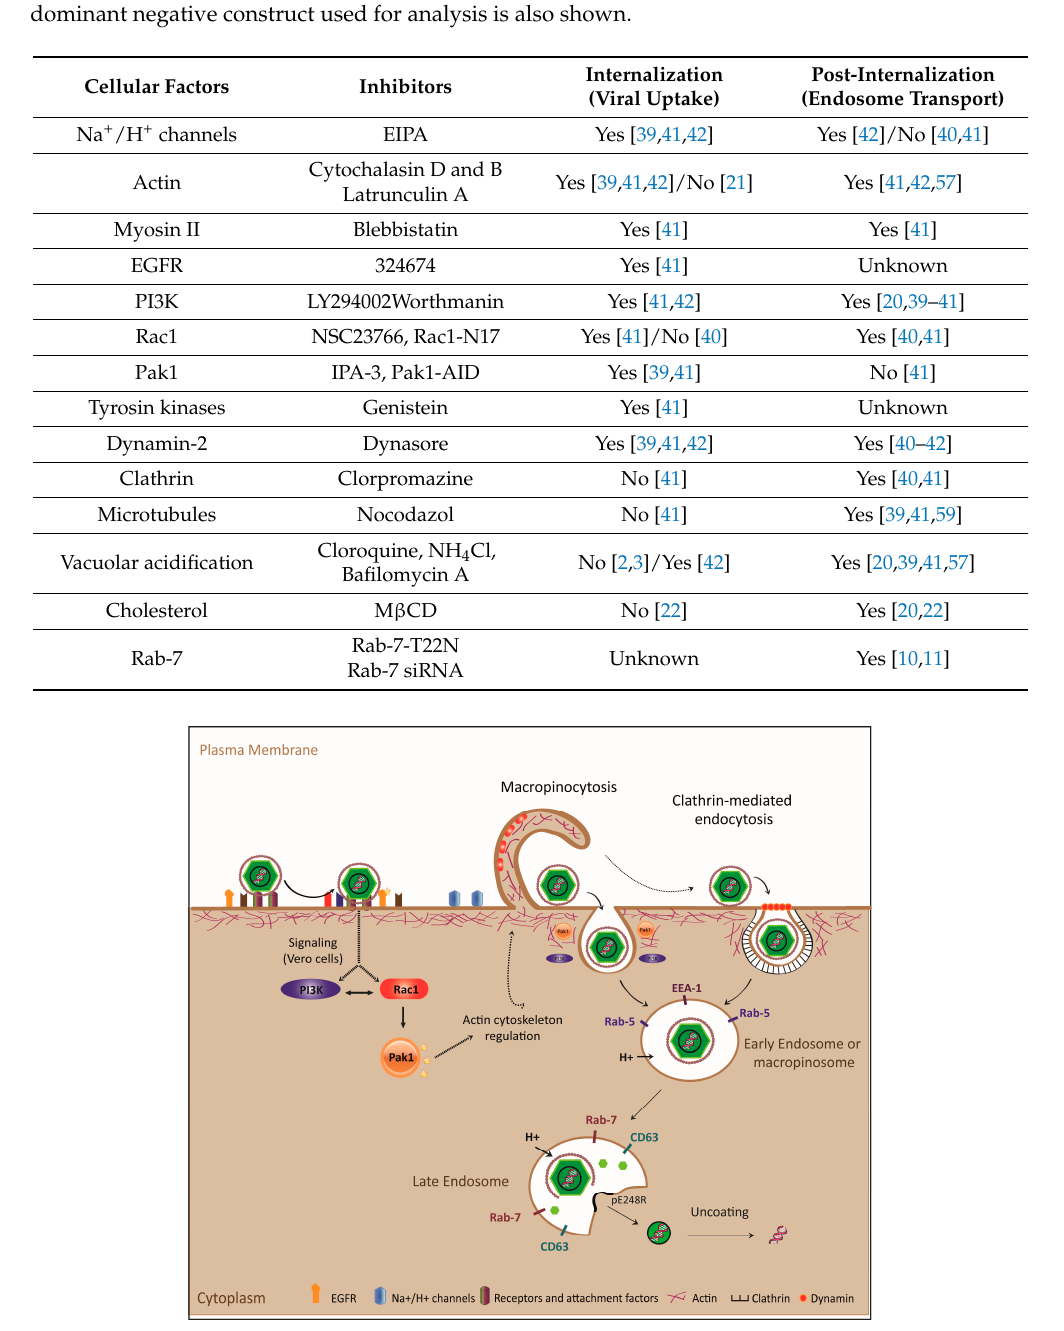
Figure 3. Model for ASFV entry and uncoating. Interaction of the viral particle with membrane receptors and attachment factors activates PI3K, EGFR, Rac1 and Pak-1 signaling pathways, which regulate actin dynamics, forming ruffles to internalize by macropinocytosis in Vero cells. In the case of swine macrophages, although the virus uses macropinocytosis, it does not actively induce the pathway; ASFV is also able to enter cells by CME. After viral uptake, particles are endocytosed in early endosomes or macropinosomes and transported to late endosomes where the pH-dependent uncoating process takes place. The viral outer envelope is disassembled and the inner envelope fuses with the endosomal membrane, delivering viral cores to cytosol, where viral protein pE248R plays an important